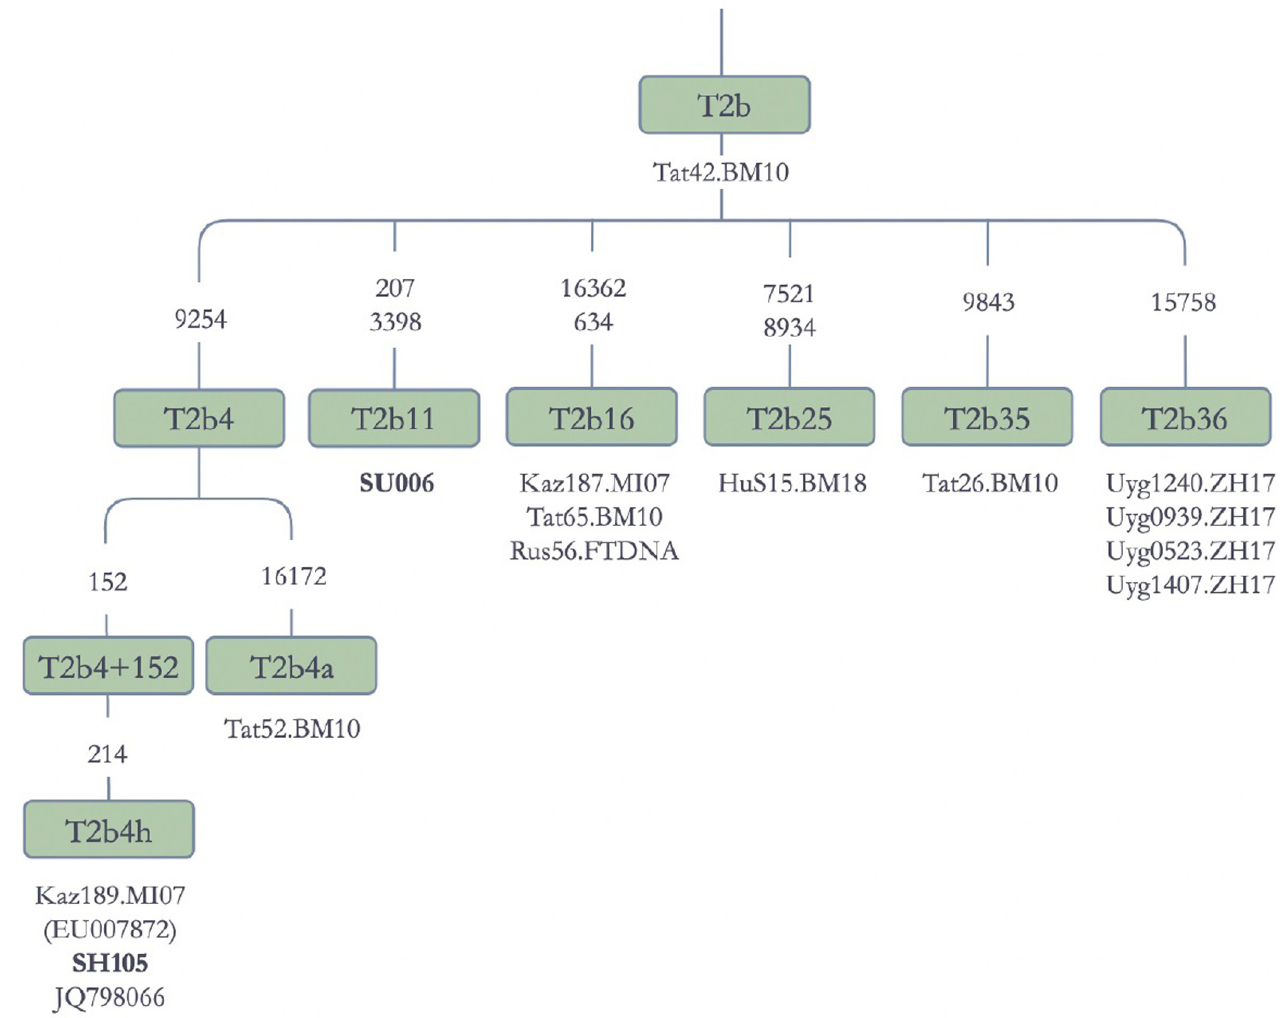
Fig 11. Schematic phylogenetic tree for the haplotype T2b. Note: Kaz: Kazak; Hu: Hungarian; Rus: Russian; Tat: Tatar; Uyg: Uyghur; SU006 and SH105 are Jetisuu sequences; EU007872 and JQ798066 are sequences from the Phylotree Build 17.0